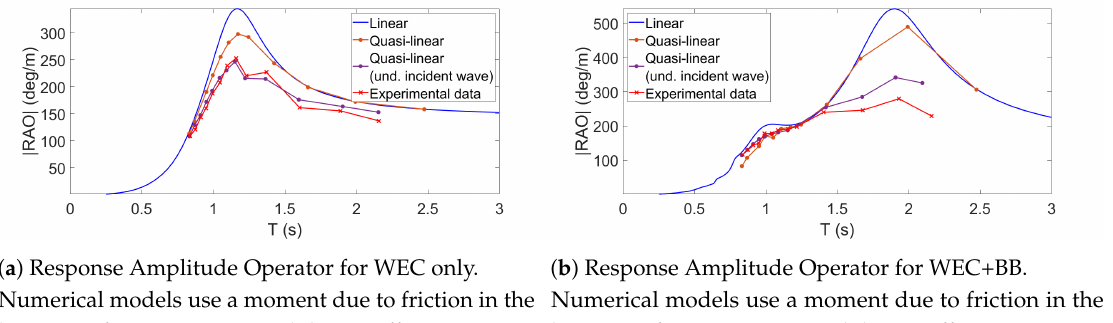
Figure 25. Response Amplitude Operators (RAO) for the WEC setup ( a ) and WEC+BB setup ( b ) for varying wave period ( T ). The solid blue line (“Linear”) is RAO calculated with potential theory using WAMIT and the red-cross line includes experimental results for regular waves (“Experimental data”). “Quasi-linear” refers to the model where all forces are linear except a simplified quadratic drag moment. The rust-coloured dotted line includes linear regular waves whereas the purple-dotted line implements the measured wave profile from undisturbed wave experiments (“und. incident